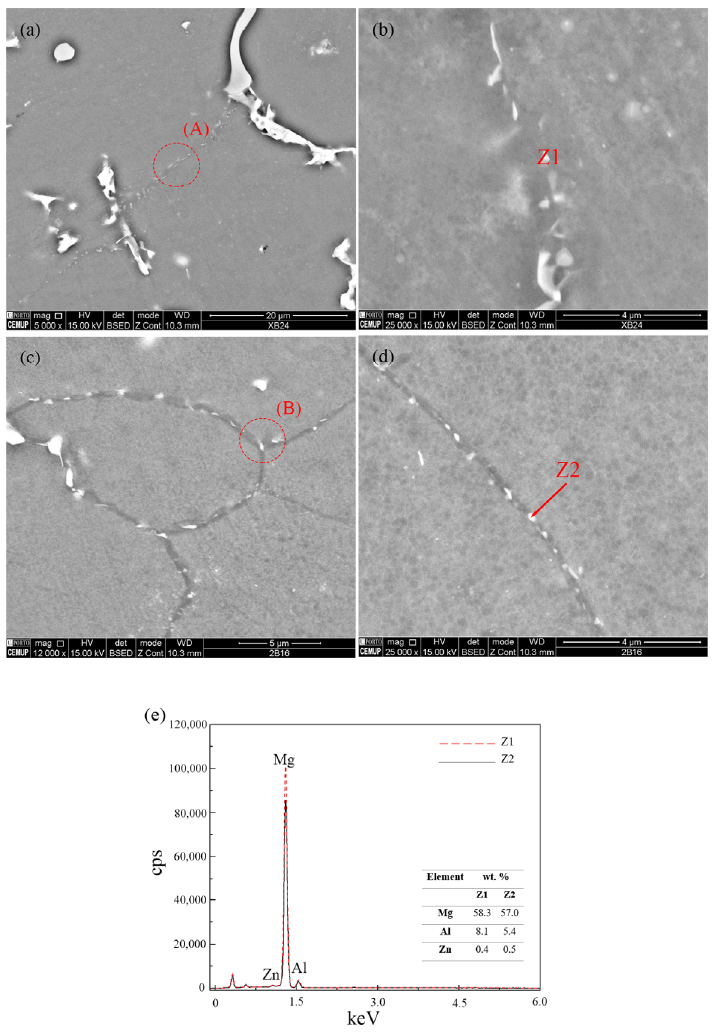
Figure 3. SEM micrographs of the discontinuous β -Mg 17 Al 12 precipitates found in ( a , b ) non- and ( c , d ) US-treated samples, after aging at 175 ◦ C for 1440 and 960 min, respectively; ( b , d ) higher magnification images of areas A and B, respectively, ( e ) EDS analysis of the particles identified as Z1 and Z2 in ( b , d ).